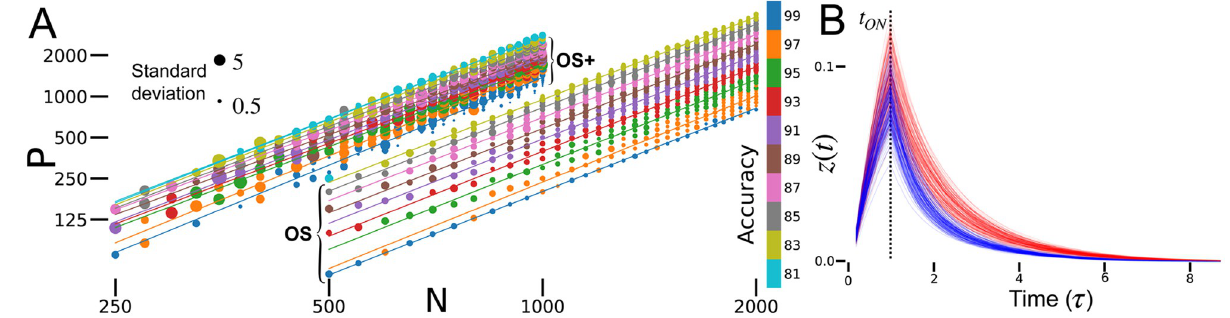
Fig 5. Hebbian-trained performance. A: Accuracy for OS and OS+ methods at various combinations of N and P . Colors represent accuracy, grouped in bins spanning 2%. Lines are fitted to every group of binned accuracies, with all slopes > 2 and regression r > 0.98. Size of the scatter points is proportional to the standard deviation (inset). f = 0.1. OS: n = 10. OS+: n = 5, � = 0.02, # epochs = 150. B: Output of a Hebbian-based sparse RNN over time. Input is on for τ . N = 1000, f = 0.1, α =